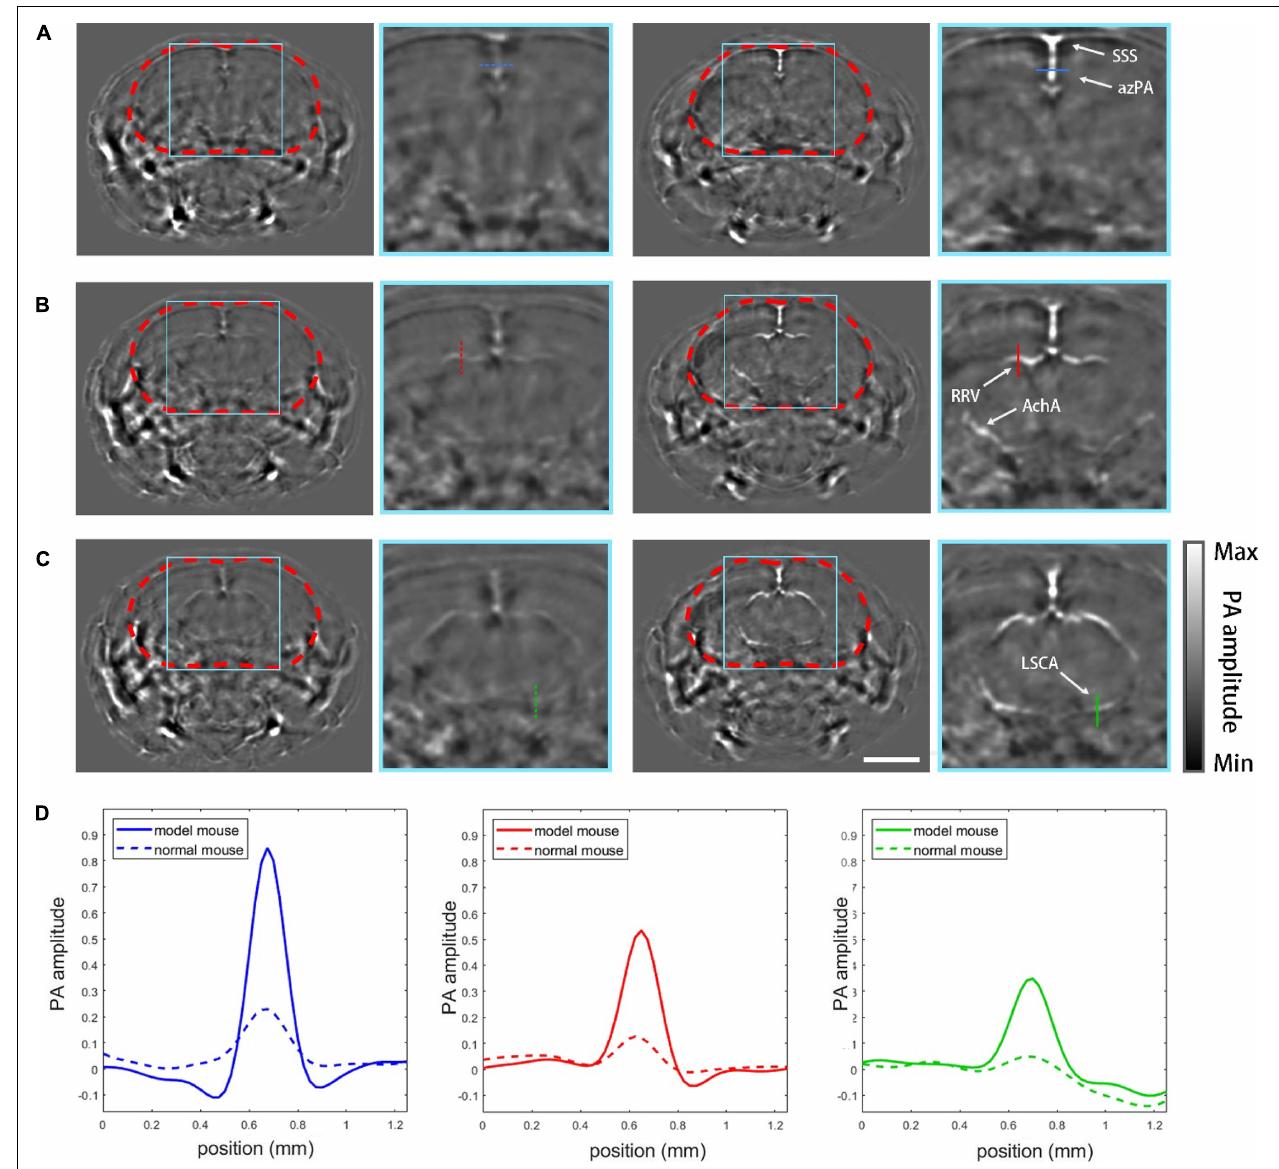
FIGURE 4 | PACT imaging results. (A) PACT images of plane (a, Figure 2A ) with zoomed-in views of normal mouse (left column) and the mouse model (right column). SSS, superior sagittal sinus; azPA, azygos pericallosal artery. (B) Images of plane (b, Figure 2A ): RRV, rostral rhinal vein; AchA, anterior choroidal artery. (C) Images of plane (c, Figure 2A ): LSCA, lateral superior cerebellar artery. (D) Profiles of the vessels marked in the PACT images by different colors. Scale bar =